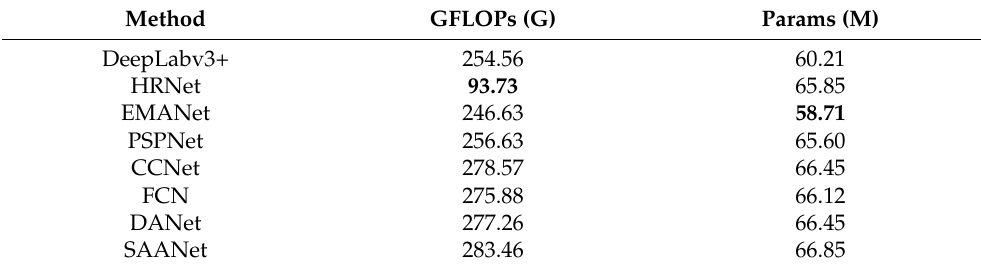
Table 4. Comparison with other networks on GFLOPs and Params. The best results are shown in